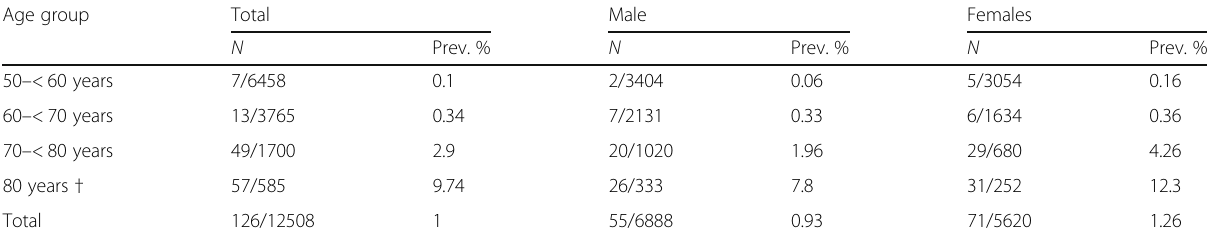
Table 2 Age and sex-specific prevalence of Alzheimer ’ s dementia in Upper Egypt, Desert areas (AL Kharga and AL